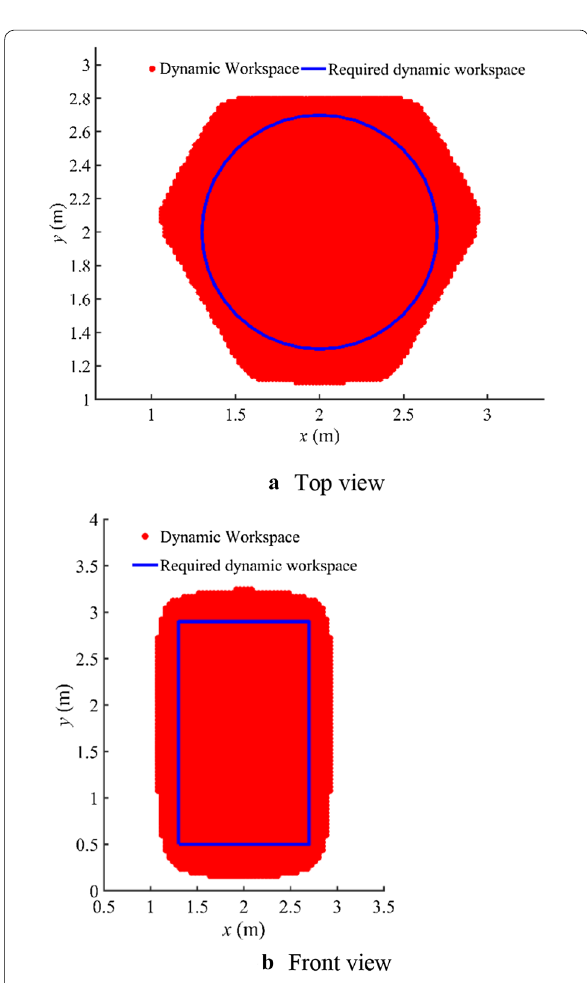
Figure 6 Directional views of dynamic workspace